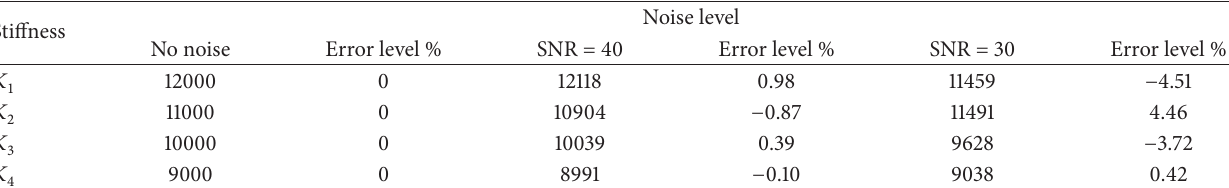
Table 2: Structural stiffness identification